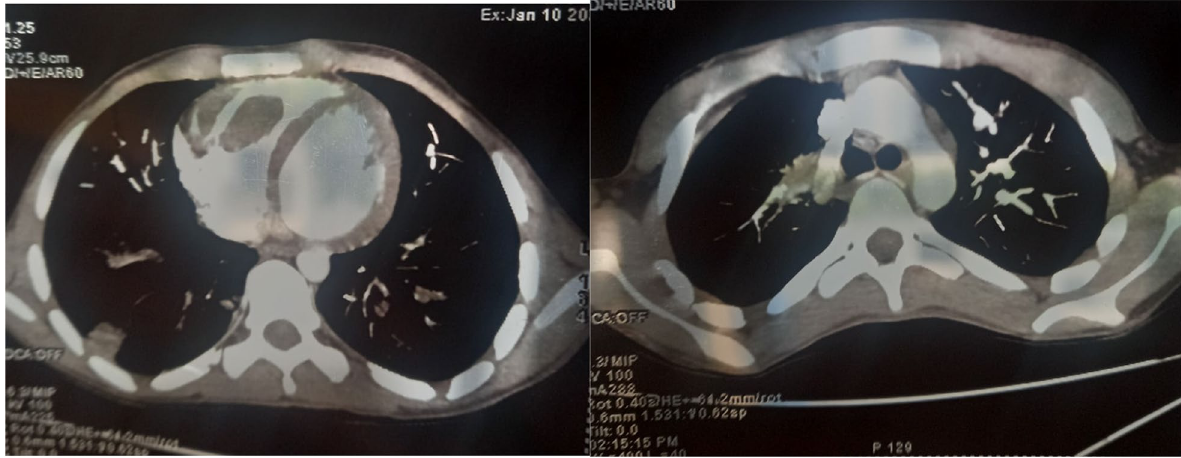
Fig. 2 Thoracic Angio CT: bilateral pulmonary embolism associated with right ventricular